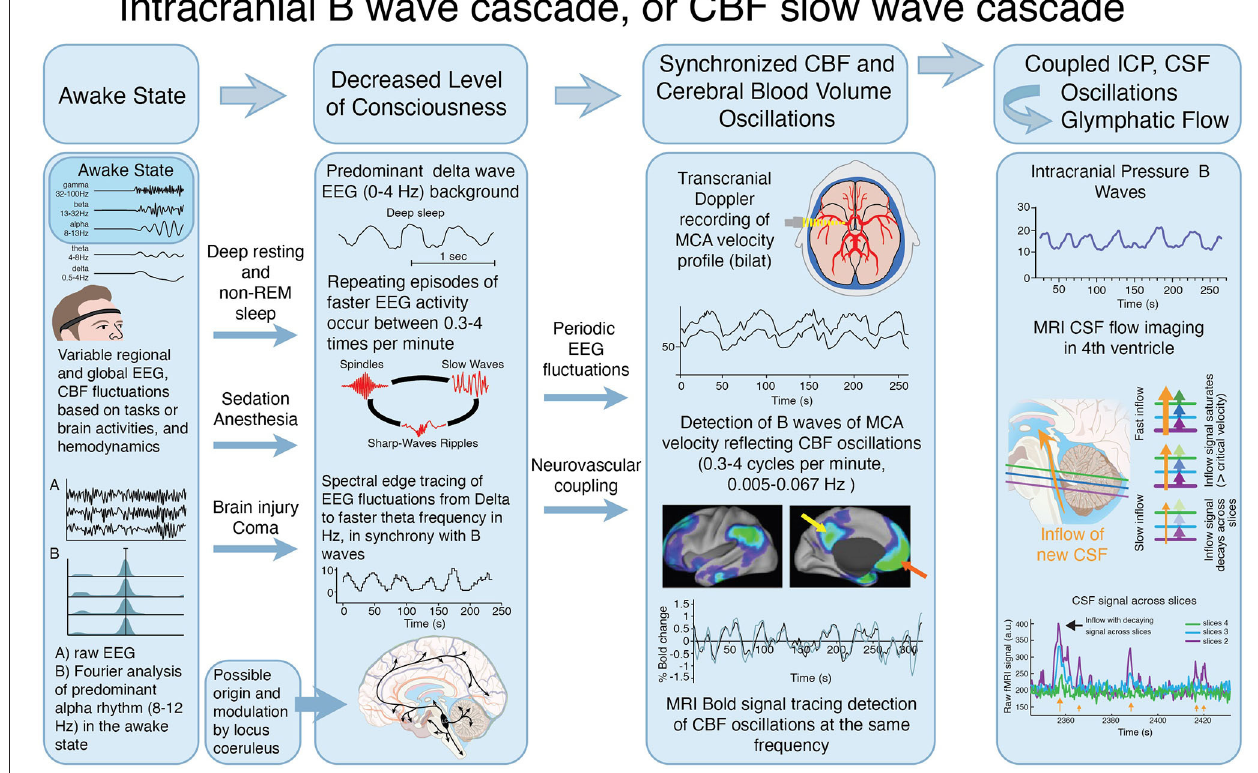
FIGURE 6 | Proposed interactions between clinical state, EEG activity, CBF oscillations and CSF movement effecting glymphatic flow. Illustration of the proposed cascade of physiological events that combine to produce the slow oscillations known as Intracranial B waves or CBF slow waves , associated with CSF movement, that may provide a significant hydrodynamic driver of glymphatic flow. This proposed cascade was constructed as a possible explanation for the fact that B waves of the MCA velocity, and CBF slow waves, have both been reported in deep resting or sleep in normal individuals. They are also observed after, sedation, anesthesia, and other conditions that are associated with reduced level of consciousness including head injury. Both states are associated with delta wave EEG, with cyclic intermittent faster frequencies which appear to drive the CBF fluctuations (see also Table 2 ). In the awake state (far left) , multiple EEG frequencies and rhythms, including predominant alpha frequencies (8–12Hz), operate during the myriad of brain functions which occur simultaneously, when glymphatic flow is minimal. The level of consciousness decreases, (center left) during deep relaxation and non-REM (delta wave) sleep, after sedation or anesthetics, and following brain injury or global brain dysfunction, during various stages of coma. During decreased level of consciousness, the EEG shifts into a predominant delta wave (0–4Hz) baseline pattern, as inputs from deep brain regions including locus coeruleus reduce their excitatory input. During delta wave EEG predominance, intermittent oscillations of faster EEG activity including spikes and spindles occur at the same repeating cyclic frequency as reported for B waves measured by TCD (in cm/sec), and CBF slow waves measured by f-MRI (0.3–4 cycles per min, 0.005–0.067 Hz * ) (center right) (with permission). These low frequency cyclic oscillations of faster electrical activity drive a repeating cycle of arterial vasodilatation and constriction at the same frequency. The resulting cerebral volume fluctuations, cause an accompanying localized hydrodynamic force, which may contribute to CSF movements (far right) from the periarterial CSF space through the brain interstitial space. These CSF pulsation movements can be measured in the ICP (mm/Hg) (upper) , and are indirectly observed using MRI imaging of CSF movement in the 4th ventricle (lower) . (With permission) * Several reports indicate lower frequency values of 0.2 cycles per min using TCD, however the majority indicate lower frequency limits of 0.3 cycles per